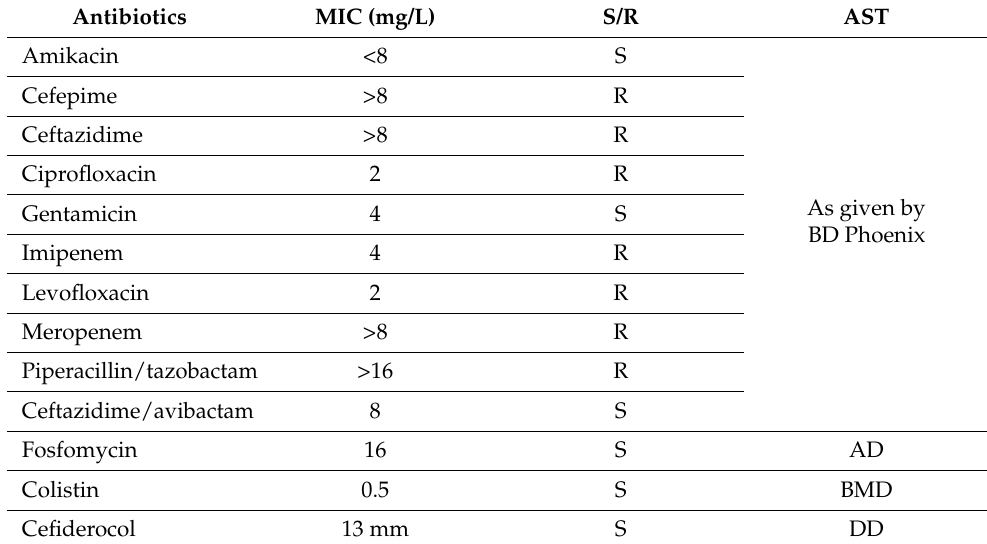
Table 2. Pseudomonas aeruginosa antibiotic susceptibility. MIC: minimum inhibitory concentration; S: susceptible; R: